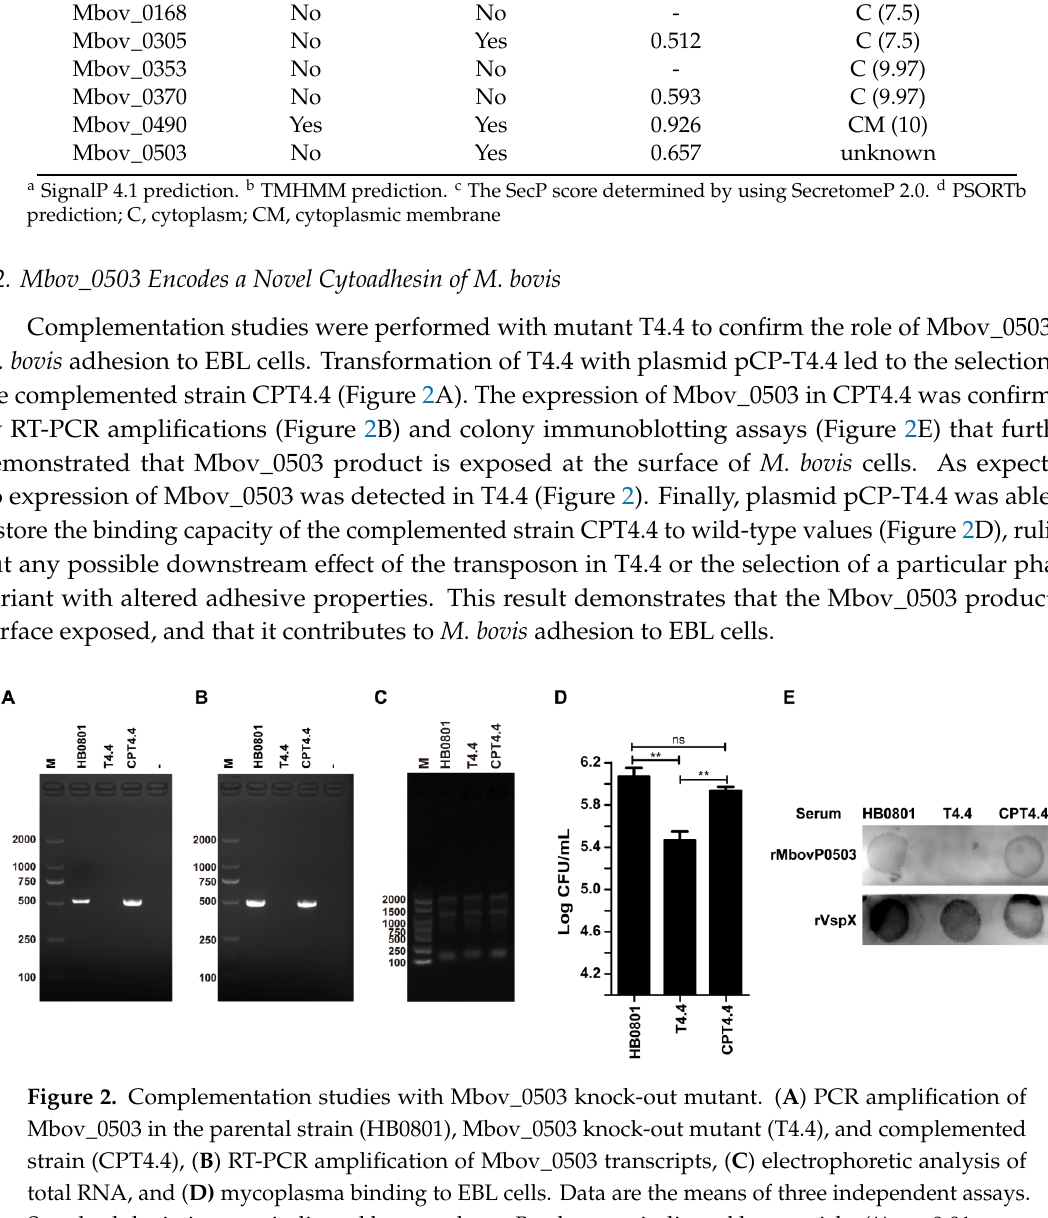
Figure 3. Immunoreactivity of rMbovP0503. ( A ) SDS ‐ PAGE analysis of purified rMbovP0503. ( B ) Western blotting analysis of rMbovP0503 reactivity with the rMbovP0503 antiserum, ( C ) cattle antiserum against HB0801, and ( D ) negative cattle serum. The unrelated M. bovis recombinant protein rMbovP328 was used as a negative control. M: prestained protein ladder.